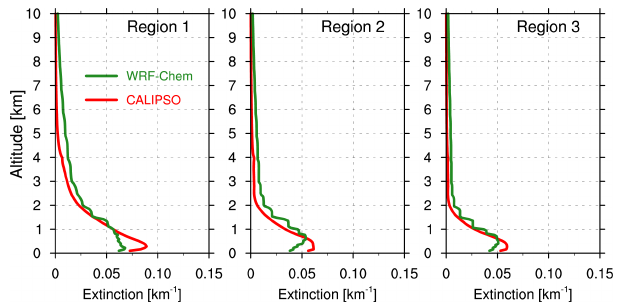
Figure 12. Vertical distributions of annual mean aerosol mass (black solid line; upper x axis) and its composition fractions (col- ored shade-contour; lower x axis) from the WRF-Chem simulation averaged for the period 2010–2014 over three sub-regions as shown in Fig. 4.